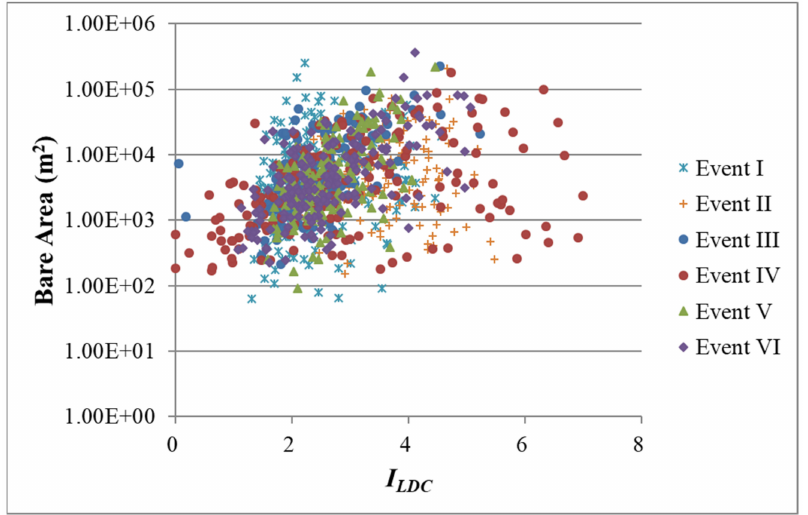
Figure 7. Plot of the bare land area against the I LDC of the overall landslide point after each